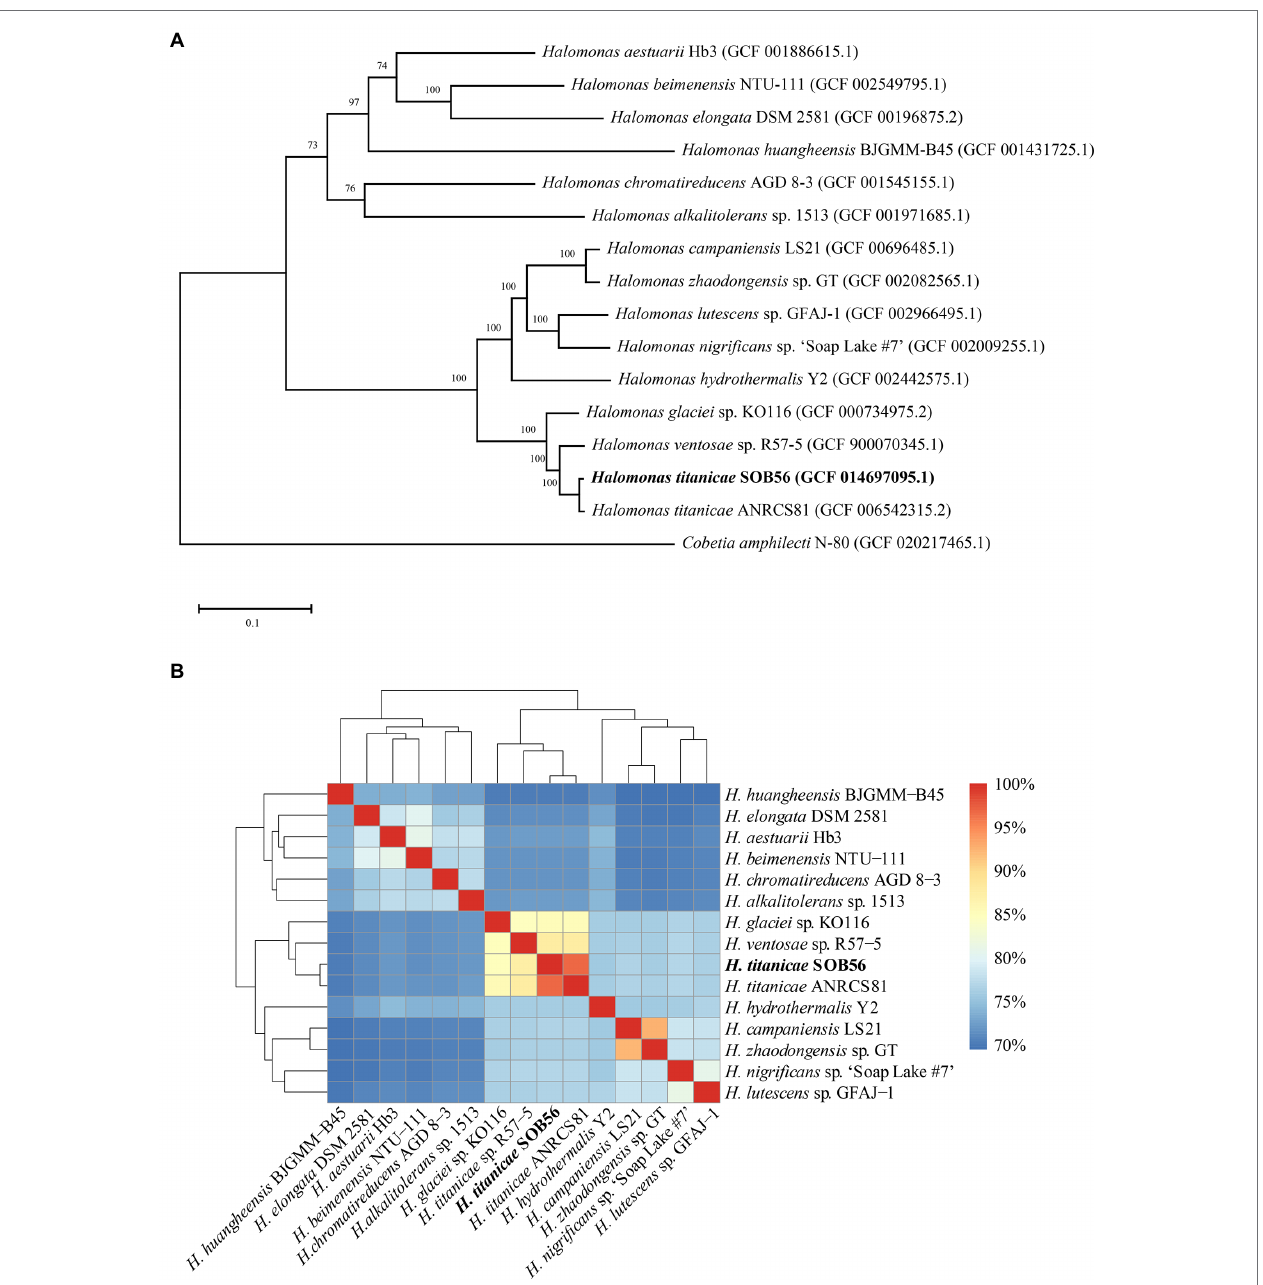
FIGURE 1 | The phylogenetic relationship of 15 complete Halomonas genomes. (A) The ML tree constructed from single-copy orthologous genes of Halomonas . Percentage bootstrap values above 50% (1,000 replicates) are shown at branch nodes, and the scale bar indicates the number of substitutions per site. (B) The ANI values among these Halomonas genomes. Cobetia amphilecti N-80 is used as